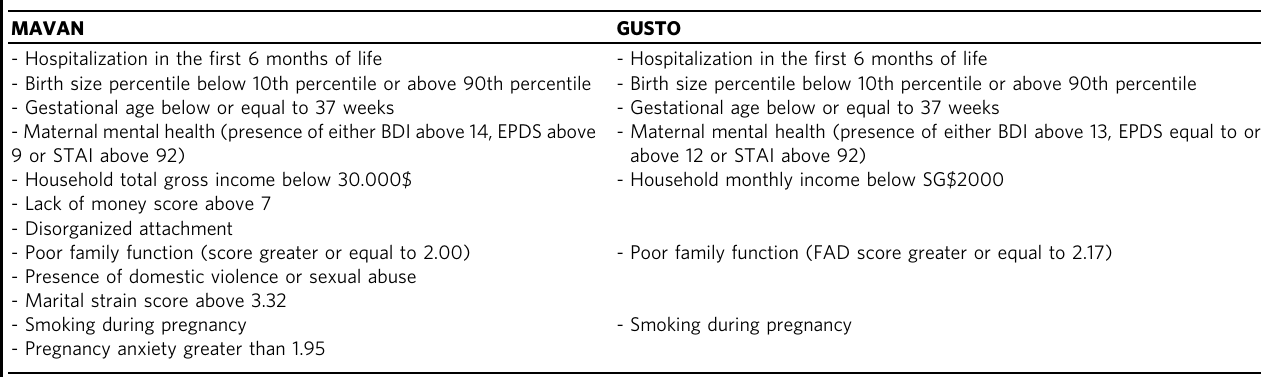
Table 1 Variables and their cut-offs used to create the Postnatal Adversity score in MAVAN and GUSTO. Postnatal Adversity Score MAVAN